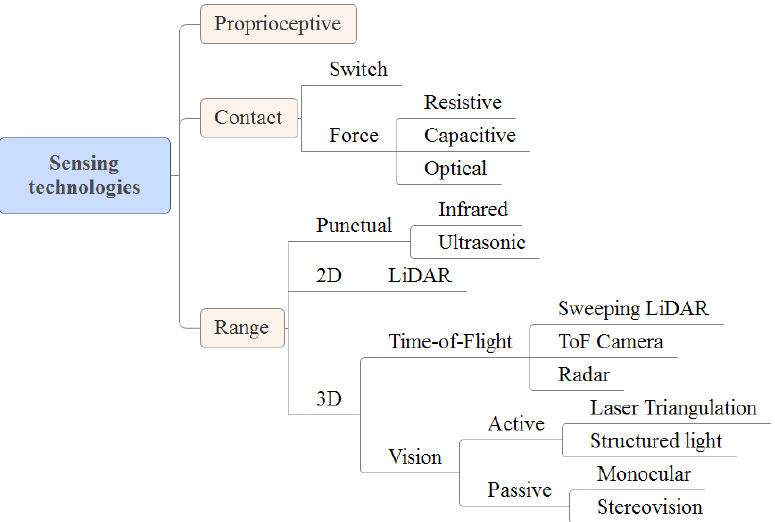
Figure 6. A taxonomy of sensors for environment perception for navigation in